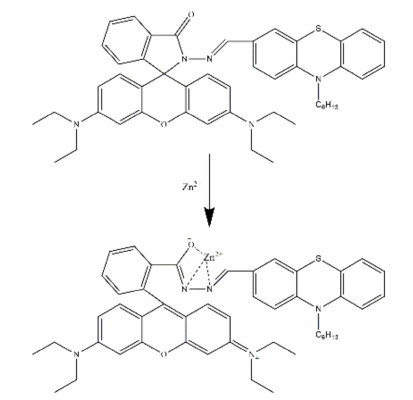
Figure 31. The proposed binding mode of PTRH (Table 1, No. 40) with Zn 2+